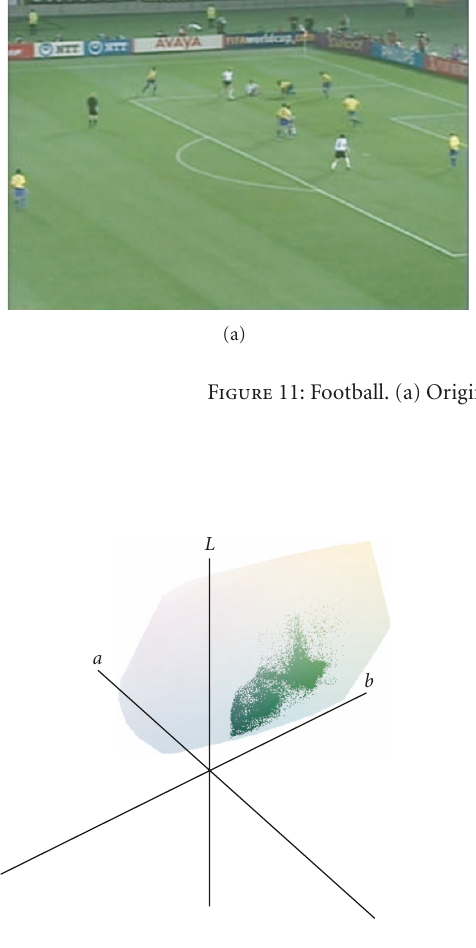
Figure 12: CIELAB illustration of the pixels featuring a green com- ponent whose membership value is above 0 .